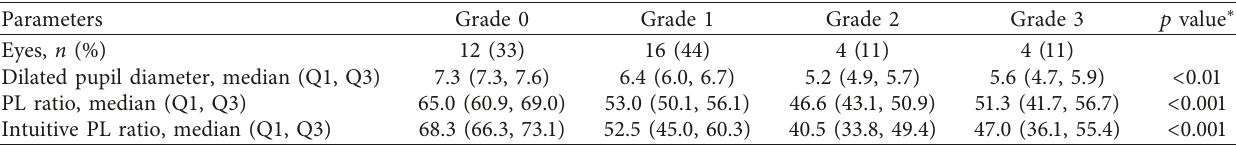
Figure 1: Bland–Altman plot. The difference between the PL ratio and the intuitive PL ratio is drawn against the mean of the PL ratio and the intuitive PL ratio in the 36 paired measurements. The blue dotted lines represent the LoA, and the dark blue dotted lines represent the 95% CI for the Table 1: Dilated pupil diameters, pupil-to-limbal diameter (PL) ratios, and intuitive PL ratios (median (Q1, Q3)) with different IFIS severity grades in the α 1-ARA group.